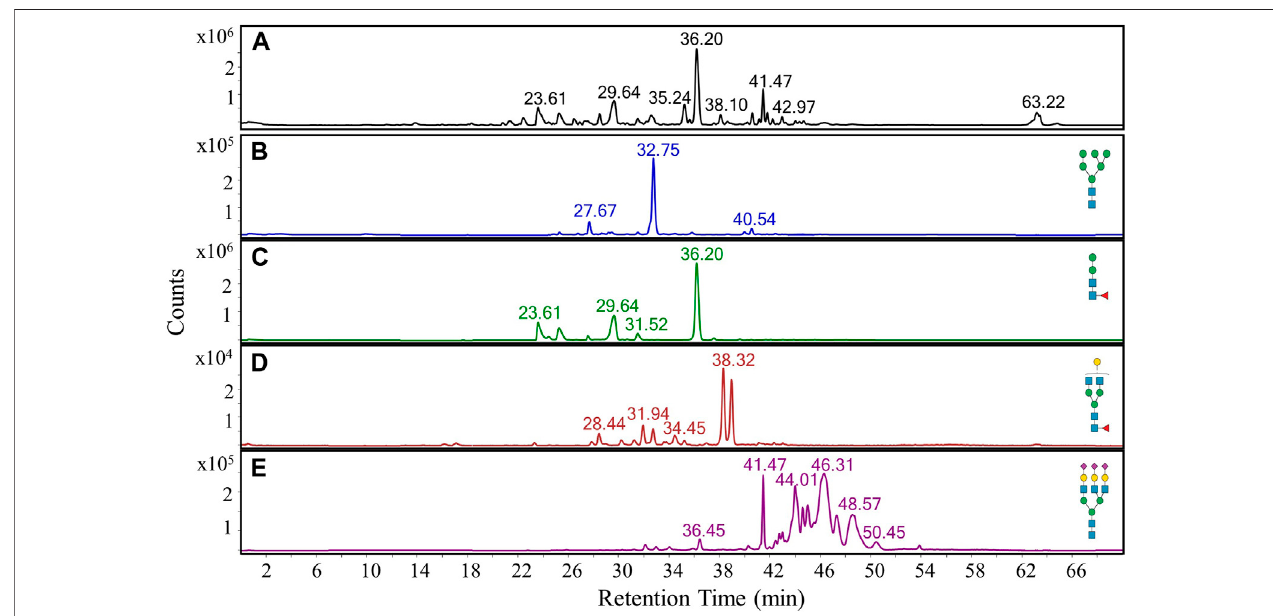
FIGURE 1 | PGC LC-MS separation and detection of N- glycans released from an in-house glycoprotein standard mixture. (A) Representative base peak chromatogramof N- glycans. (B – E) Extractedionchromatogramsoffourrepresentative N- glycans,namelyanoligomannosestructure (B) ,afucosylatedpaucimannose structure (C) , a fucosylated bi-antennary complex structure (D) , and a tri-antennary sialylated structure (E) .